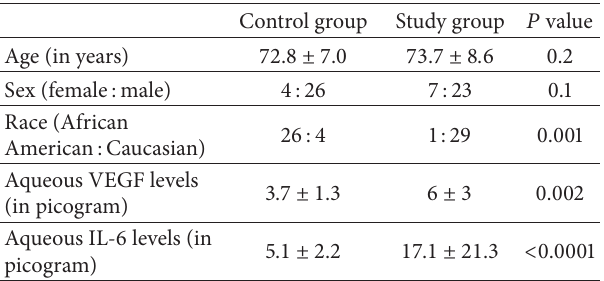
Table 1: Baseline characteristics of study and control